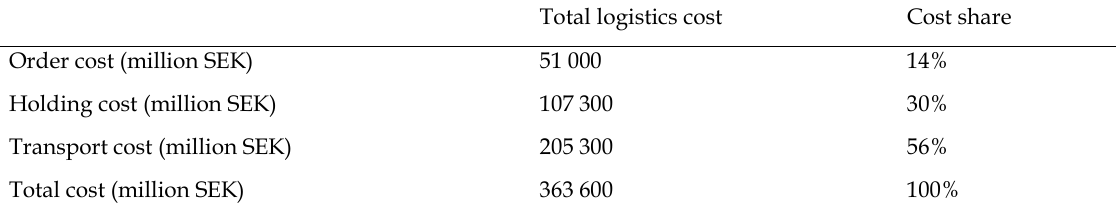
Table 3. Cost components in the base scenario for freight flows inside and outside